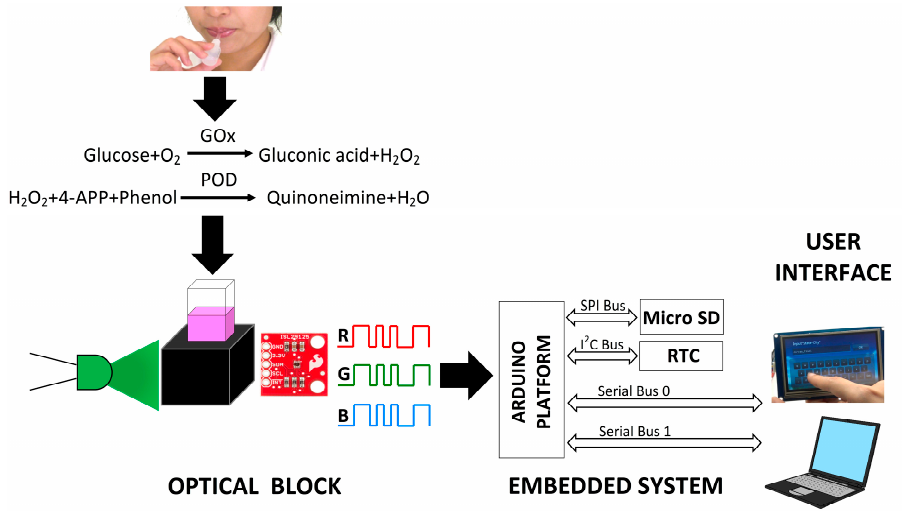
Figure 1. Schematic representation of the implementation of the RGB colorimeter.